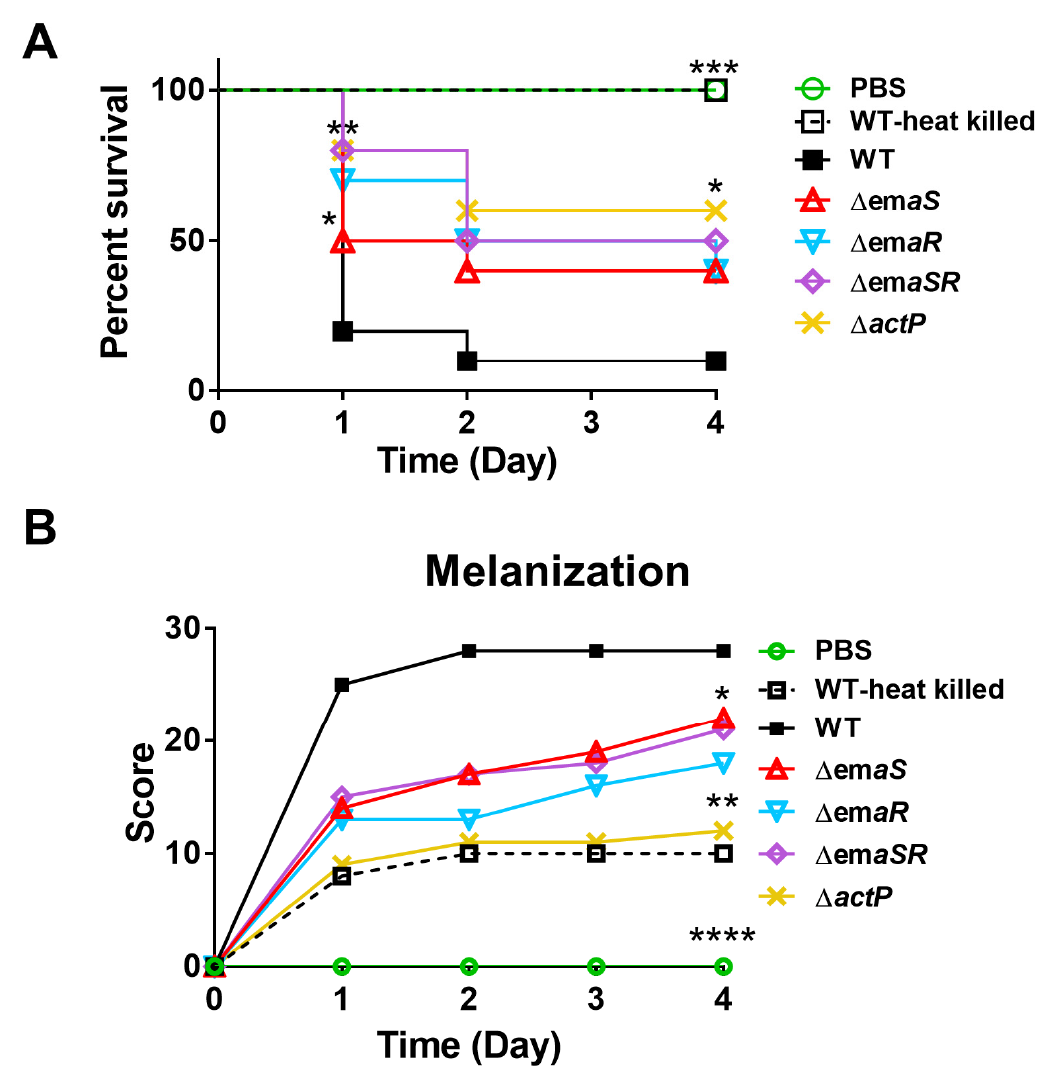
Figure 8. G. mellonella survival rates after infection with A. baumannii and mutant strains. ( A ) Kaplan-Meier survival curves, with each curve representing a single representative experiment performed with 10 larvae. ( B ) Melanization score curves, with each curve representing a single representative experiment performed with 10 larvae. * p < 0.05; ** p < 0.01; *** p < 0.001; **** p < 0.0001. Taken together, a novel TCS EmaSR was found and studied in this article. Deletion